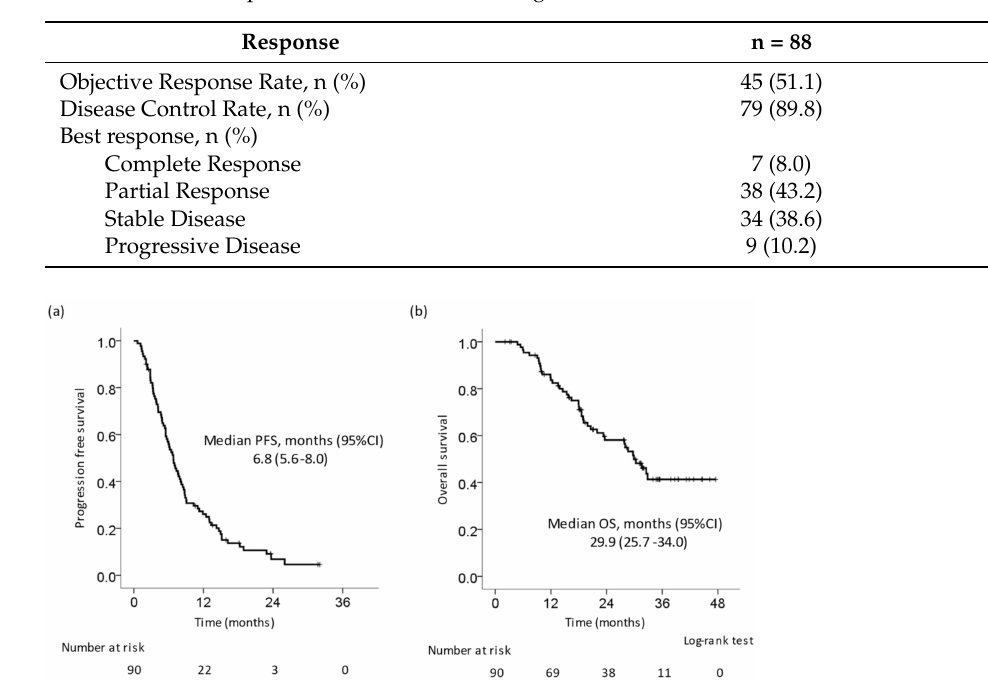
Figure 1. Kaplan–Meier curve of progression-free survival and overall survival in all